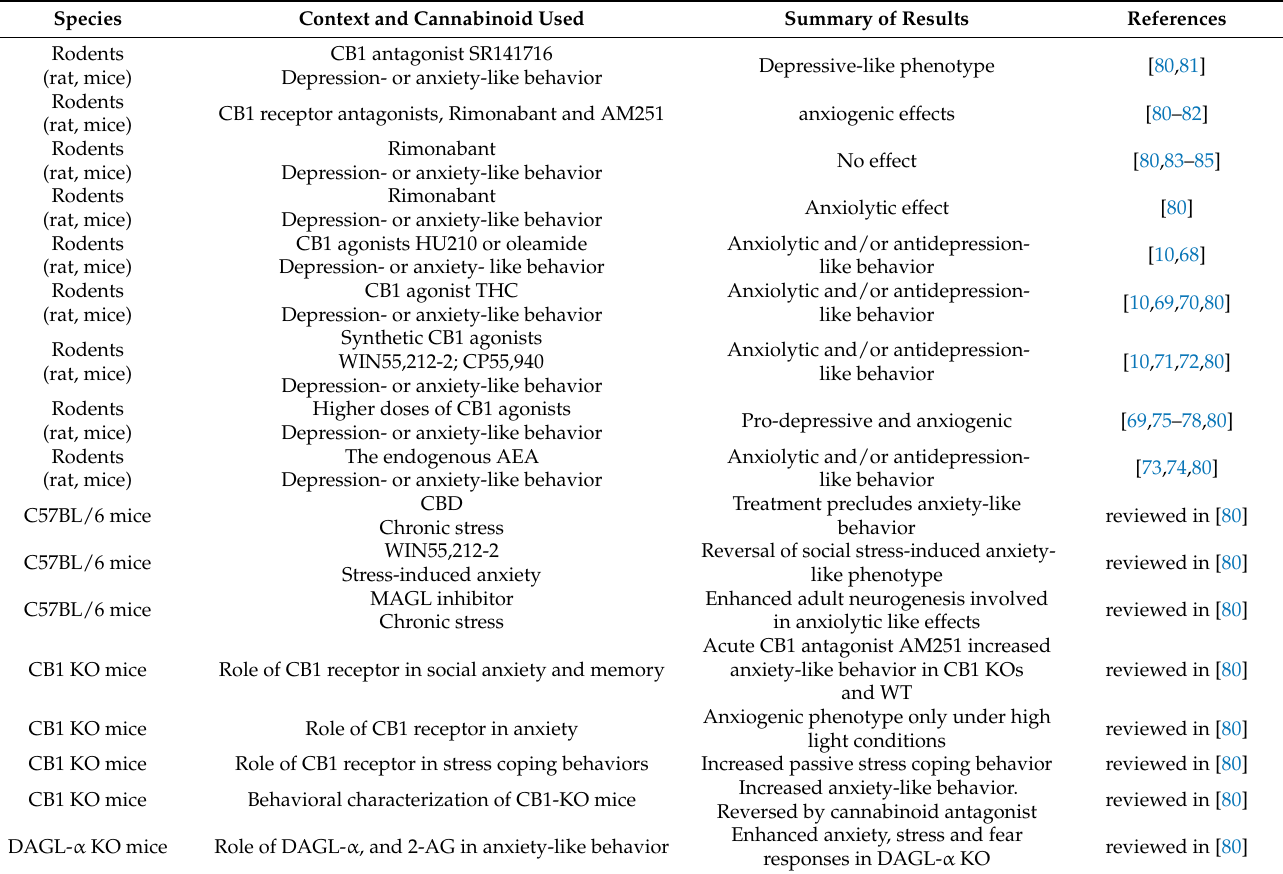
Table 1. Examples of preclinical studies showing the effects of cannabinoids on depression-like and anxiety-like